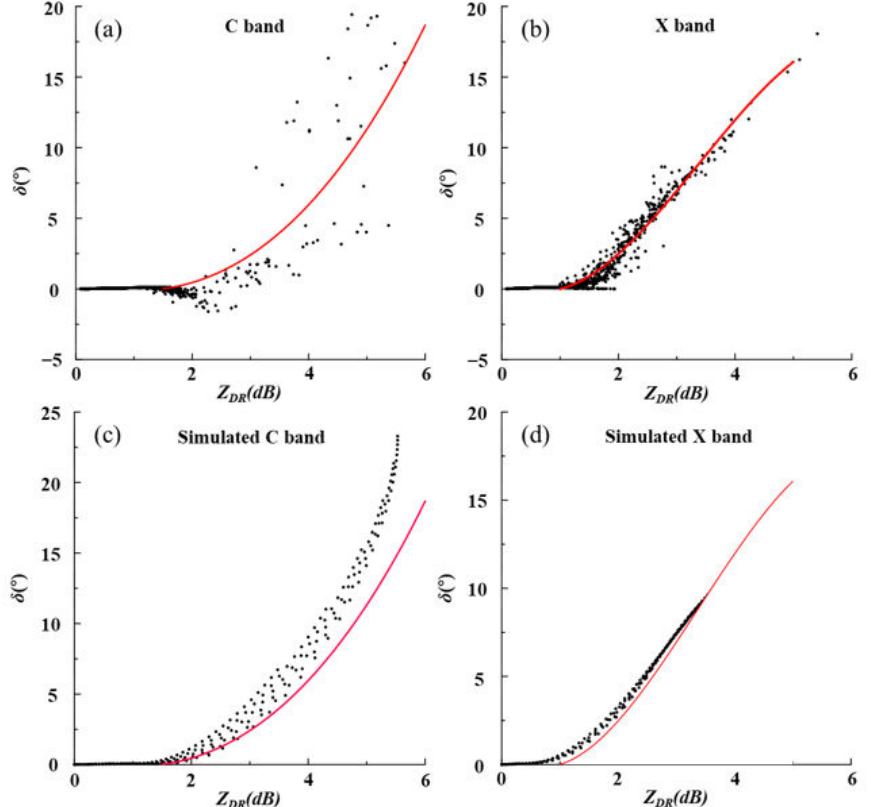
Figure 2. Scatterplots of the δ calculated from DSD measurement with Z DR for the ( a ) C-band and ( b ) X-band, and of δ calculated from gamma assumptions of DSD with Z DR for the ( c ) C-band and ( d ) X-band. The red line represents the polynomial-fitted δ –Z DR relationship